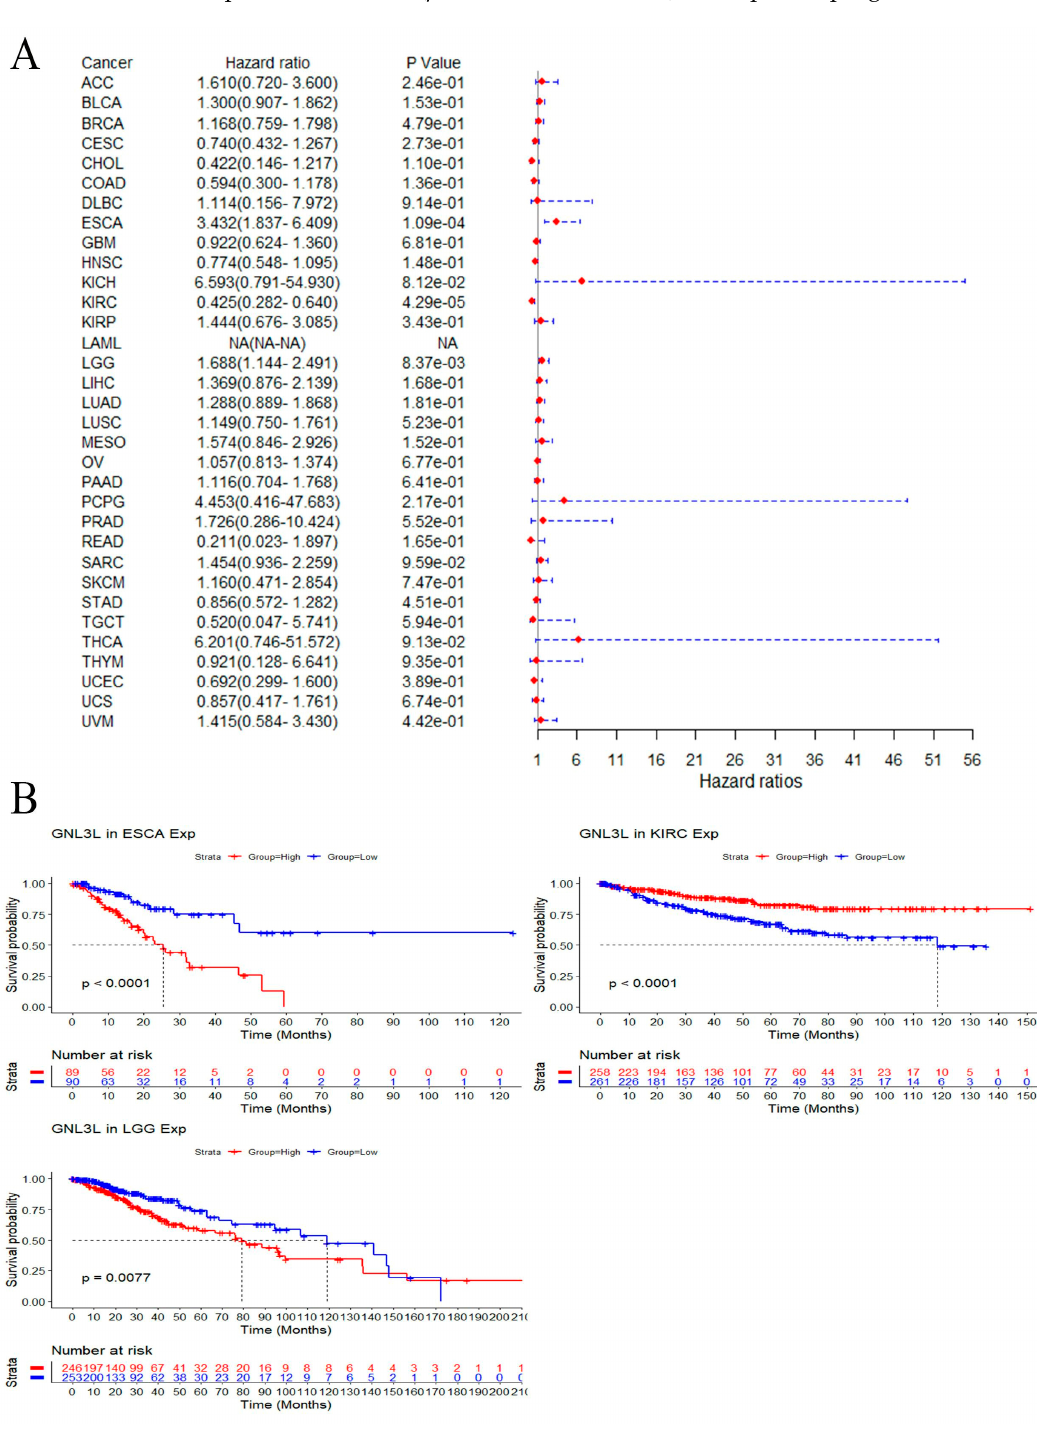
Figure 7. Correlation of GNL3L expression with DSS in patients. ( A ) Forest plot of DSS risk ratios for GNL3L in 33 cancers. ( B ) Kaplan–Meier DSS curves for patients stratified by different GNL3L expression levels in ESCA, KIRC, and LGG cancers.